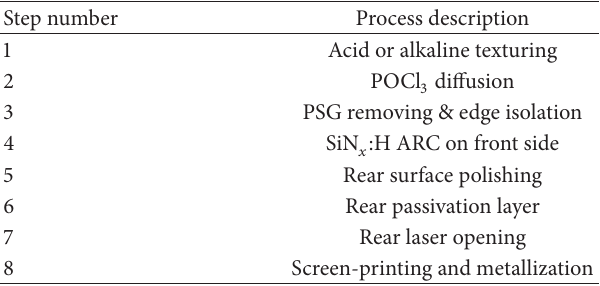
Table 2: Process sequence of PERC solar